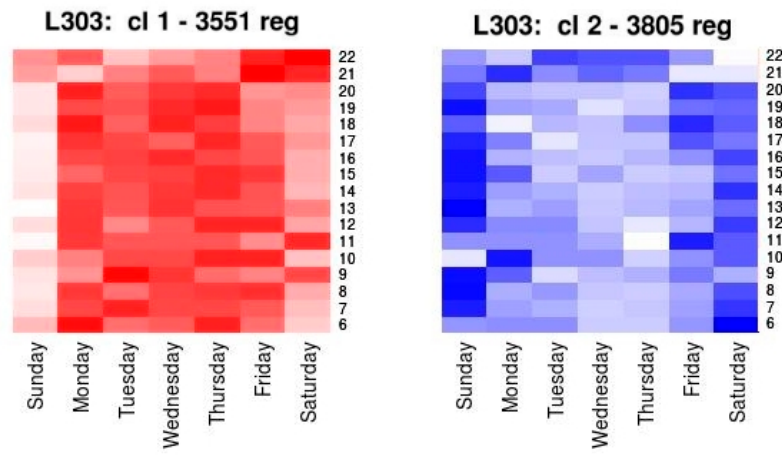
Figure 6. Heatmaps of k-medoids with two clusters, showing the relation of their records with the days of the week and the hours of the day of the